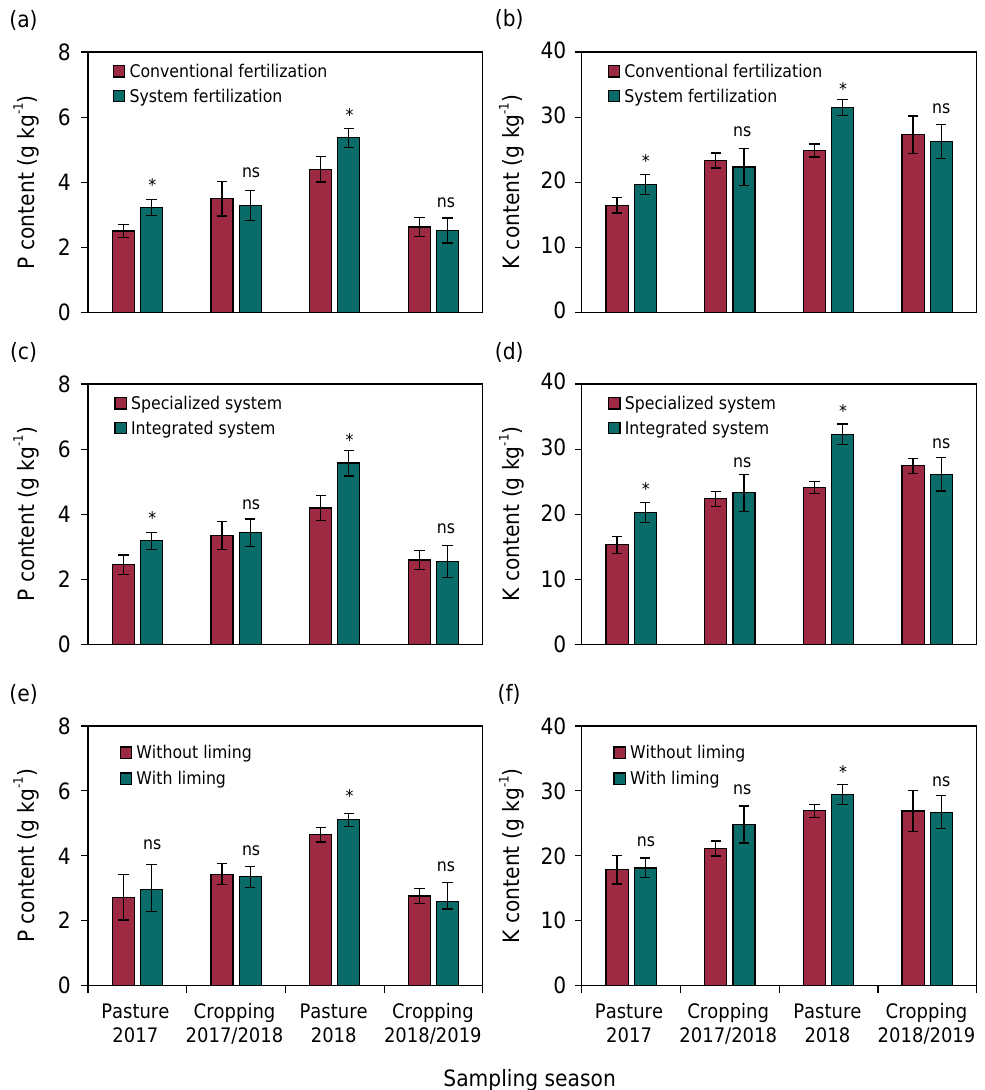
Figure 3. Phosphorus (P) and potassium (K) contents in aboveground biomass as affected by fertilization strategy (conventional or system) (a, b), animal grazing (specialized or integrated) (c, d), and liming (with or without) (e, f). Asterisks denote significant differences as per Tukey’s test